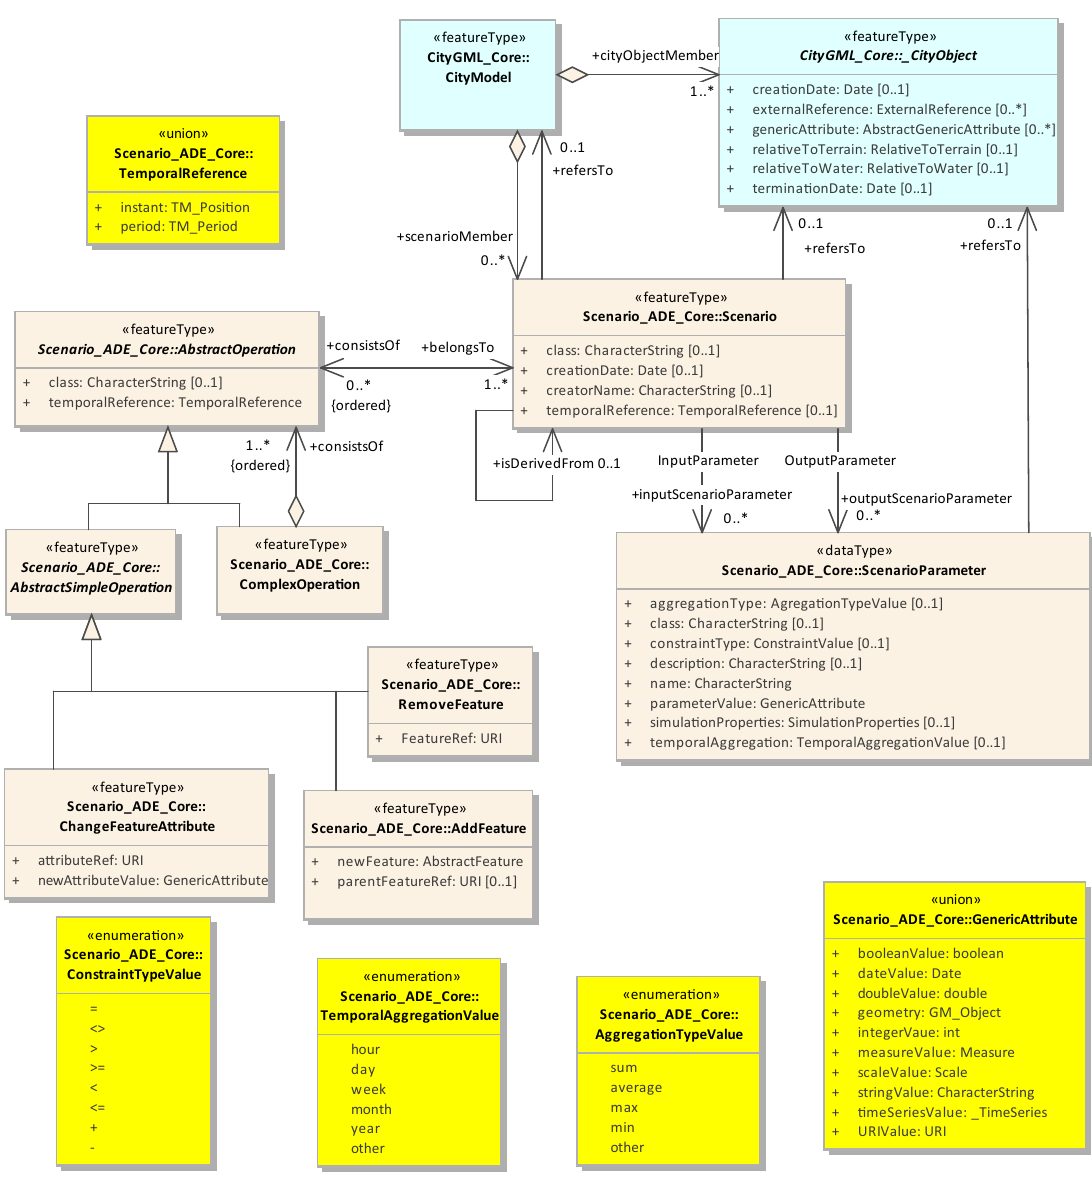
Figure 1. Excerpt of the UML diagram of the Scenario ADE, core